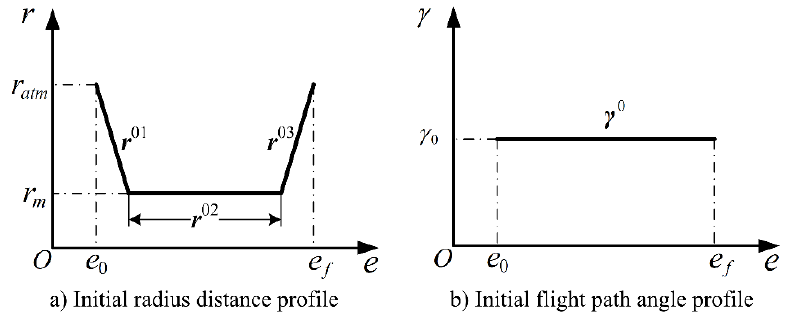
Figure 6. Illustration of the initial profile of radius distances and flight-path angle.